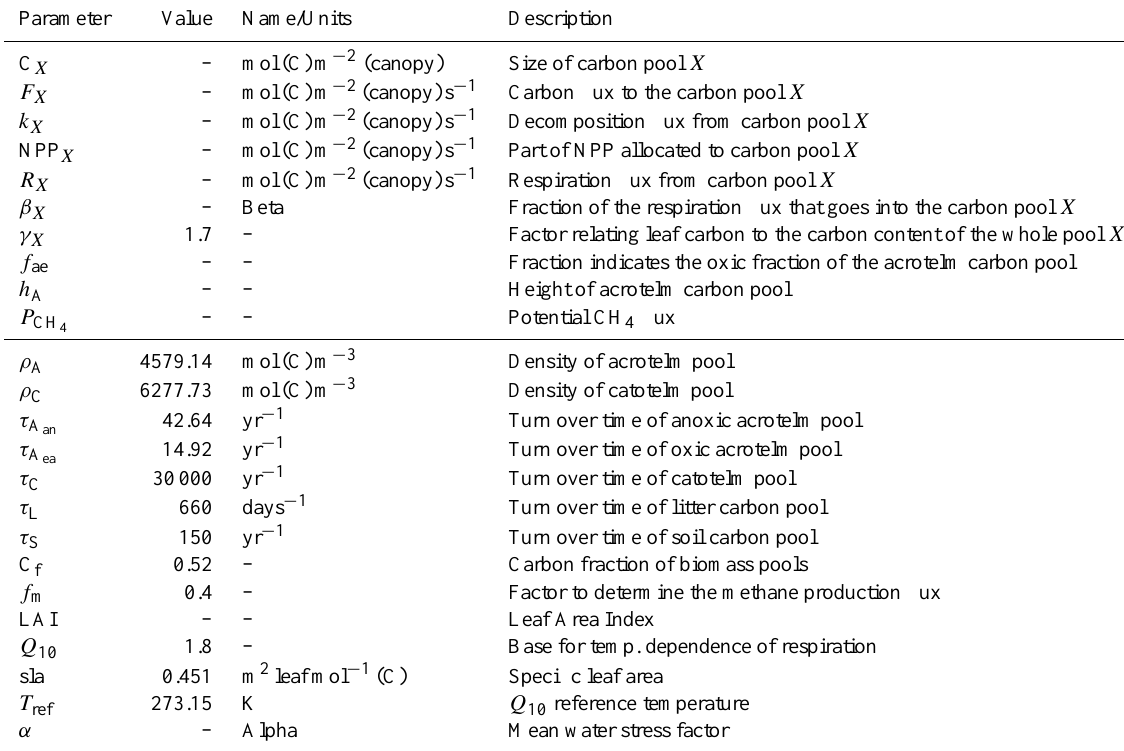
Table 2. Model variables and